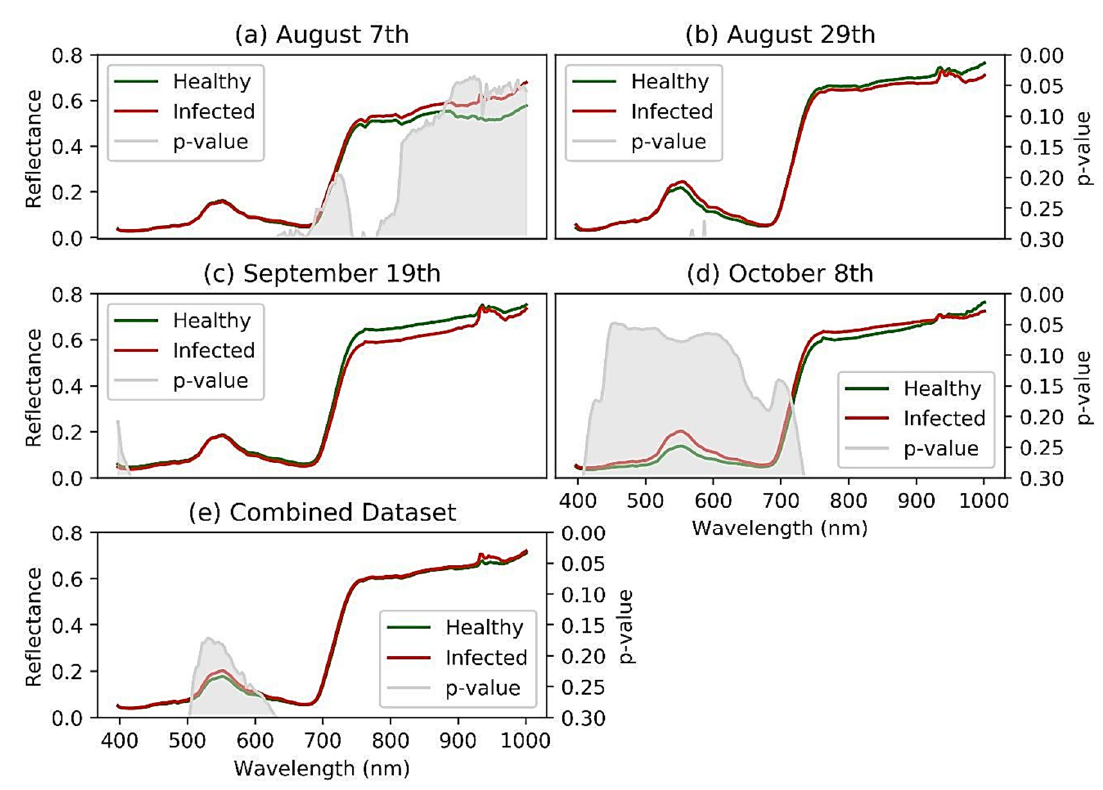
Figure 6. Reflectance spectra signature discrimination for healthy and GVCV-infected vines at the early infection stages. The 20-day interval hyperspectral measurements of 30 days after sowing (DAS) grapevines occurred on August 7th ( a ), August 29th ( b ), September 19th ( c ), and October 8th ( d ) in 2019. Data from all dates were pooled and named the “combined dataset”, ( e ) since all measurements were in asymptomatic stages. An independent sample t -test was applied to calculate p -values (in gray regions) so as to validate the confidence level for the spectral discrimination.